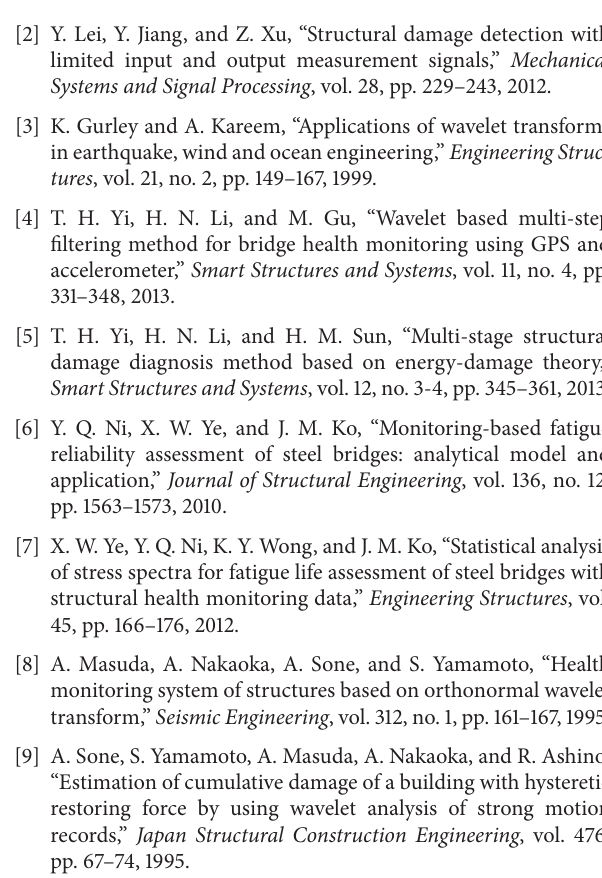
Figure 17: Detection results from contaminated acceleration responses (impulse